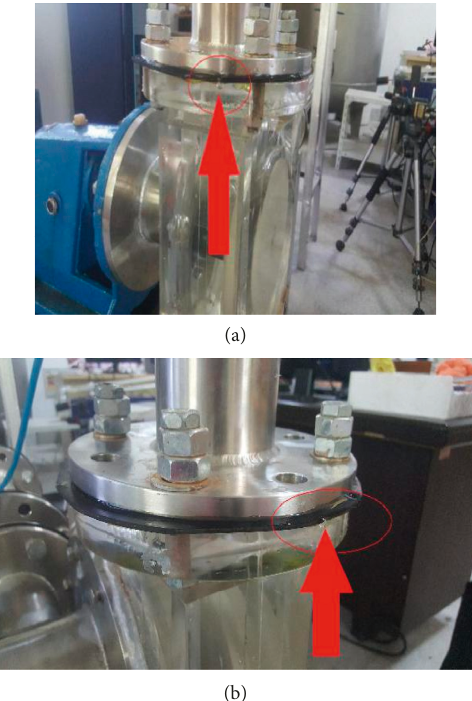
Figure 24: Water location of exit